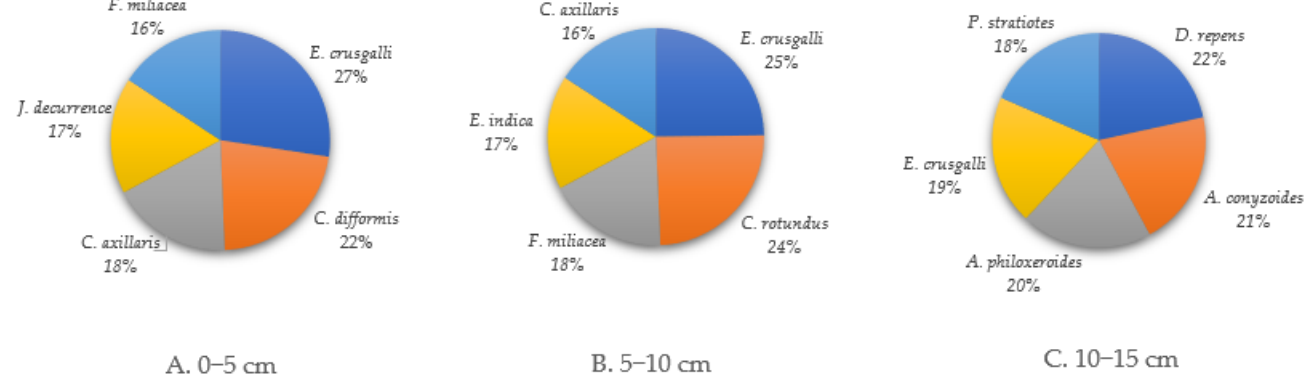
Figure 2. Five most dominant weed species based on the importance value at ( A ) 0−5 cm, ( B ) 5−10 cm, and ( C ) 10−15 cm soil depth of initial soil seed bank in 2014. Retention of 50% residue both with the CT and ST reduced the species number by two fewer species in CT + 50% residue (34 species) and by five fewer species in ST + 50% residue (19 species) relative to no-residue after 2 years (Table 3).